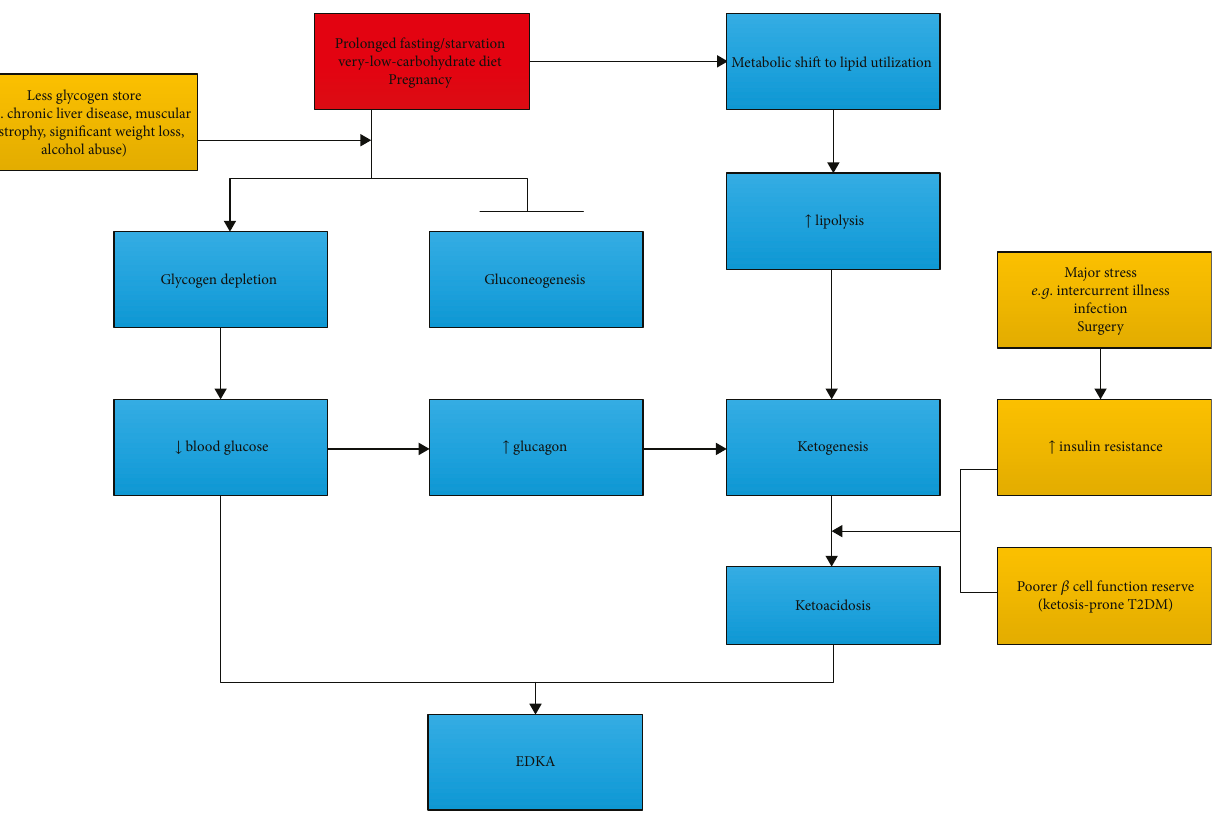
Figure 3: EDKA in a non-insulin-dependent setting: triggered by starvation or other precipitants; with the compensation capacity of EGP impaired by lack of substrates or poor liver function, a metabolic shift to lipid utilization occurs at a lower blood glucose